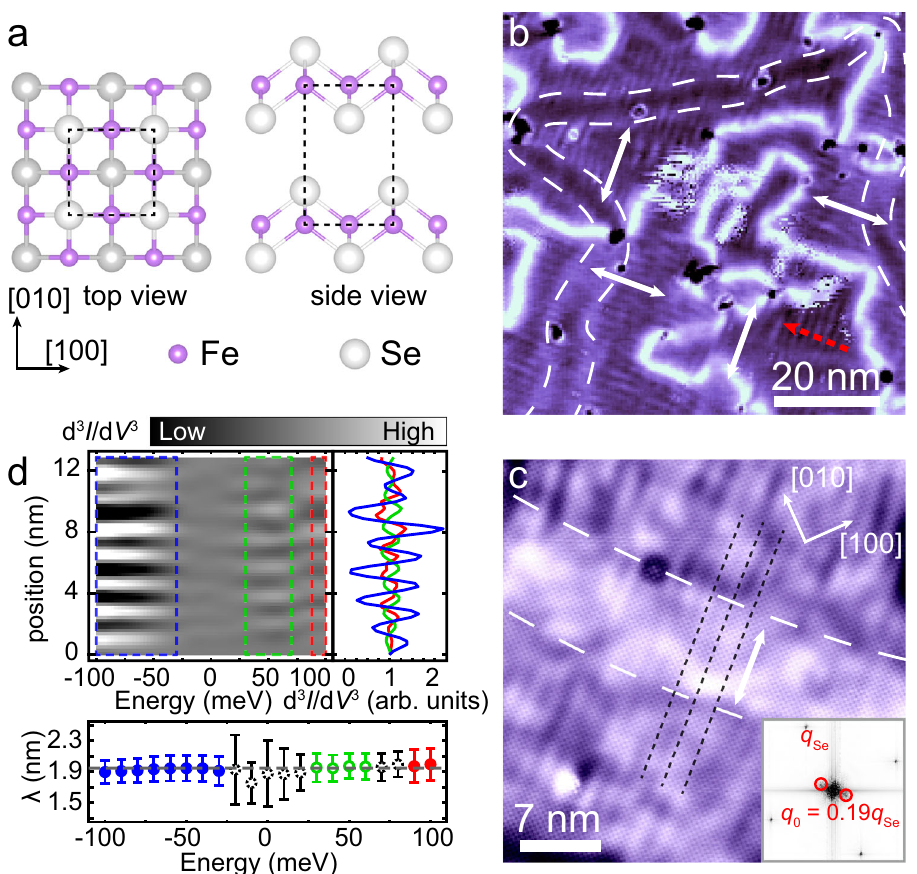
Fig. 1 Stripe patterns in 2 UC FeSe/STO. a Lattice structure of FeSe. b A STM d I /d V mapping of a 2 UC FeSe/STO at 150 meV (76 nm × 76 nm; set point, V = 150 mV, I = 400 pA). The double-headed white arrows denote the orientation of stripe ordering in different smectic domains. c Atomically resolved s t topographic image of the 2 UC FeSe/STO (35 nm × 35 nm; set point, V s = 60 mV, I t = 200 pA). The black dashed lines denote three adjacent stripes. The white dashed lines denote the DOS corrugations induced by structural boundaries in the underneath FeSe layer. The stripe patterns are continuous across the corrugation. Inset: Fast Fourier transformation result of ( c ). The q 0 = 0.19 q Se is observed along the [ − 110] direction, corresponding to the stripes with a period of λ = 2.0 nm in real space. d Upper: The second-order derivative of d I /d V (i.e., d 3 I /d V 3 ) line-cut as a function of energy [or v ( x , E )]. The corresponding route of the line-cut is shown in red dashed arrow in ( b ). Right panel: The blue, green, and red curves are the averaged d 3 I /d V 3 line-cuts in the energy ranges of − 100 to − 30 meV, 30 to 60 meV, and 90 to 100 meV, respectively. The stripes show a π phase shift in the range of 30 – 60 meV. Lower panel: The period of the stripes as a function of energy, which is determined from the peak position in the FFT result to the d 3 I /d V 3 line-cut at each energy. The error-bar denotes the peak width in the FFT. The hollow green circles denote the stripes have a π phase shift compared with those labeled in fi lled circles. The data labeled in gray dashed circles are in the transition energy ranges, in which the signals are relatively weak. And the phase shift in such ranges cannot